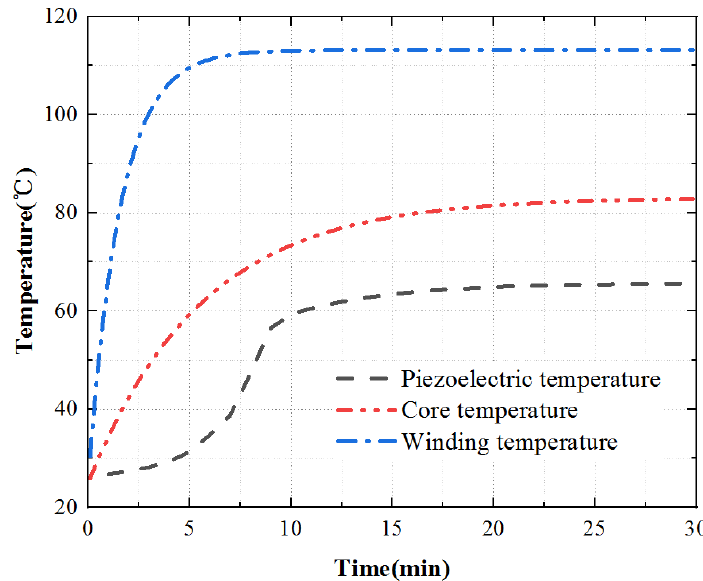
Figure 20. Temperature rise characteristic curve.